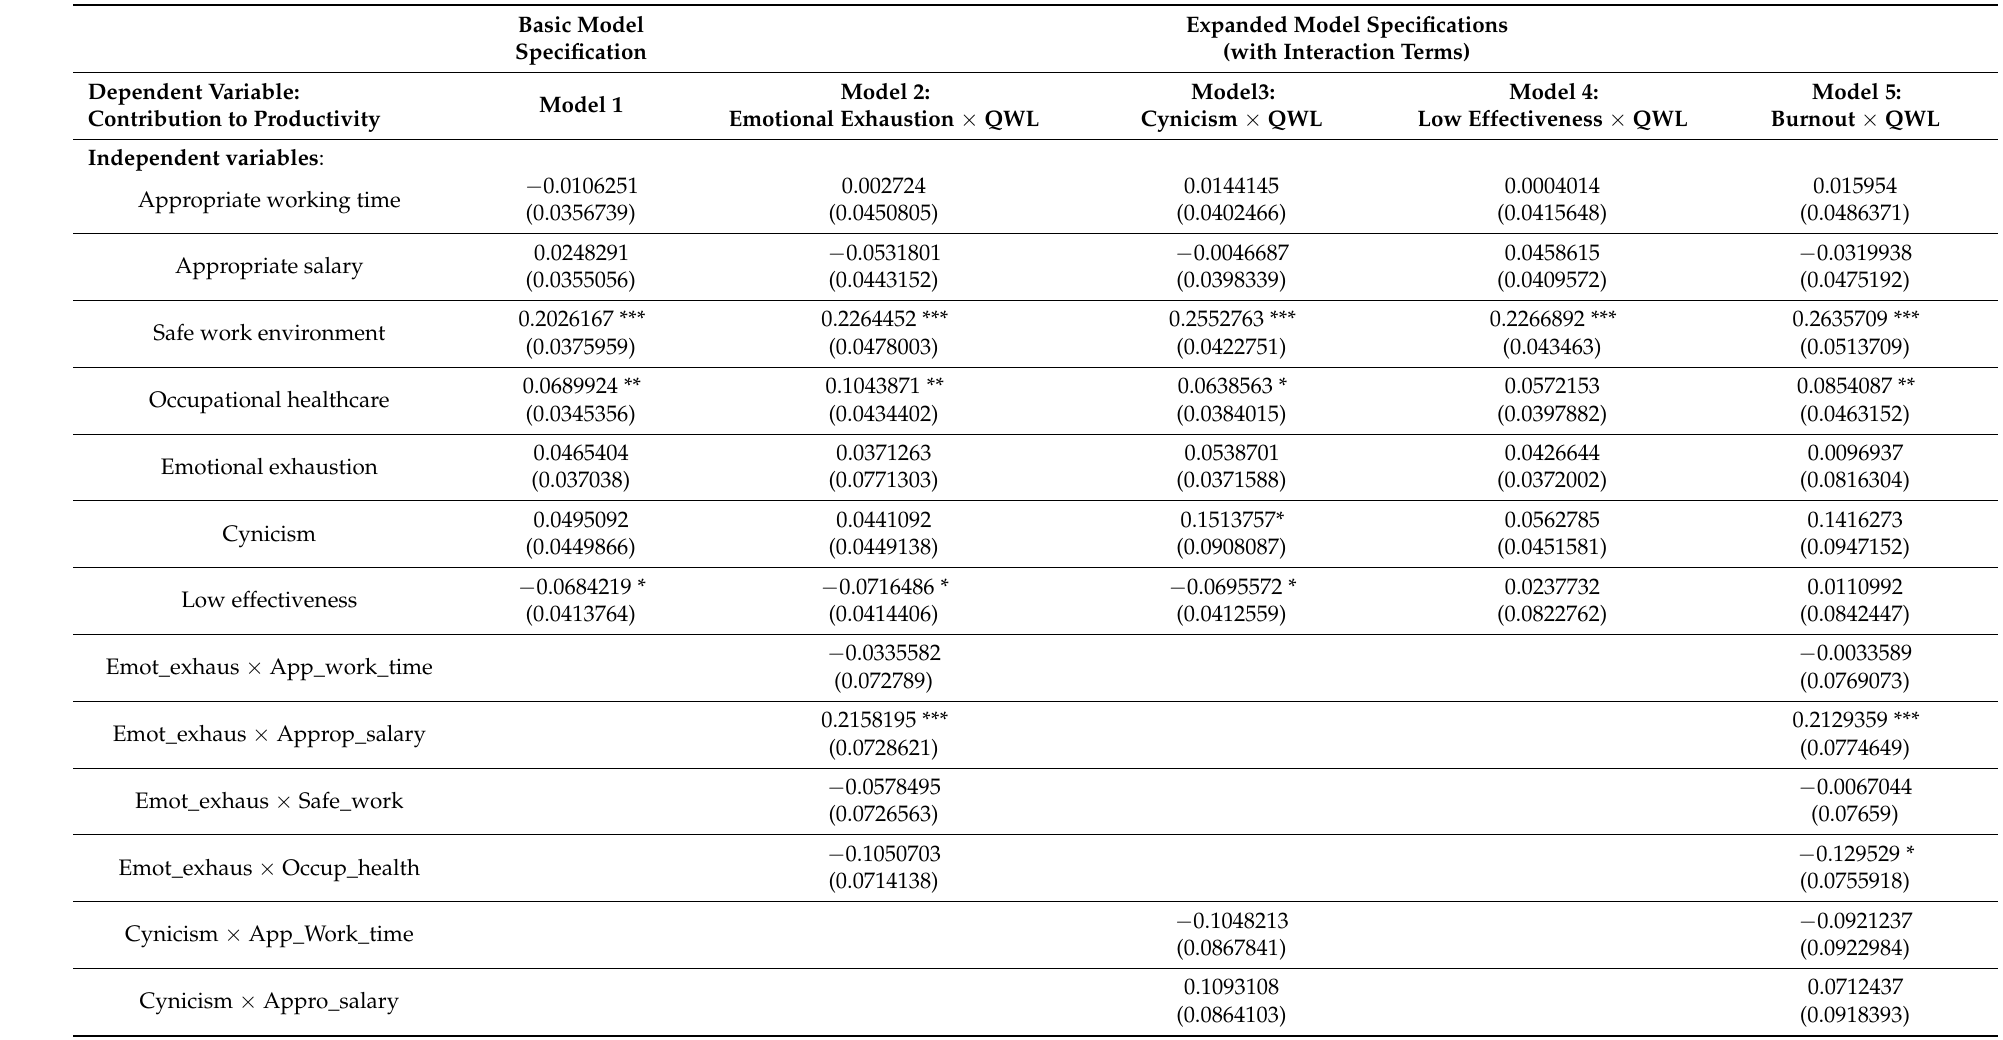
Table 4. Estimation results: basic and expanded